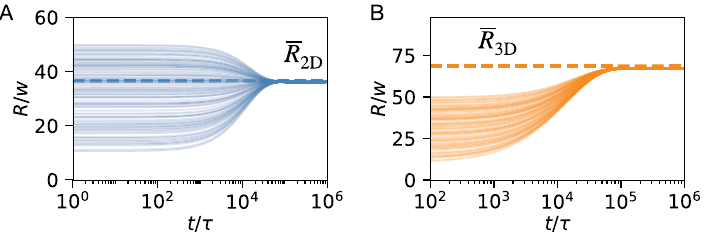
Figure 6. Suppression of Ostwald ripening by first-order chemical reactions. ( A , B ) Radii R as a function of time t of droplets evolving in d are indicated by dashed horizontal lines. 100 droplets with radii chosen uniformly in [10 w , 50 w ] were placed in a periodic cubic domain of size φ